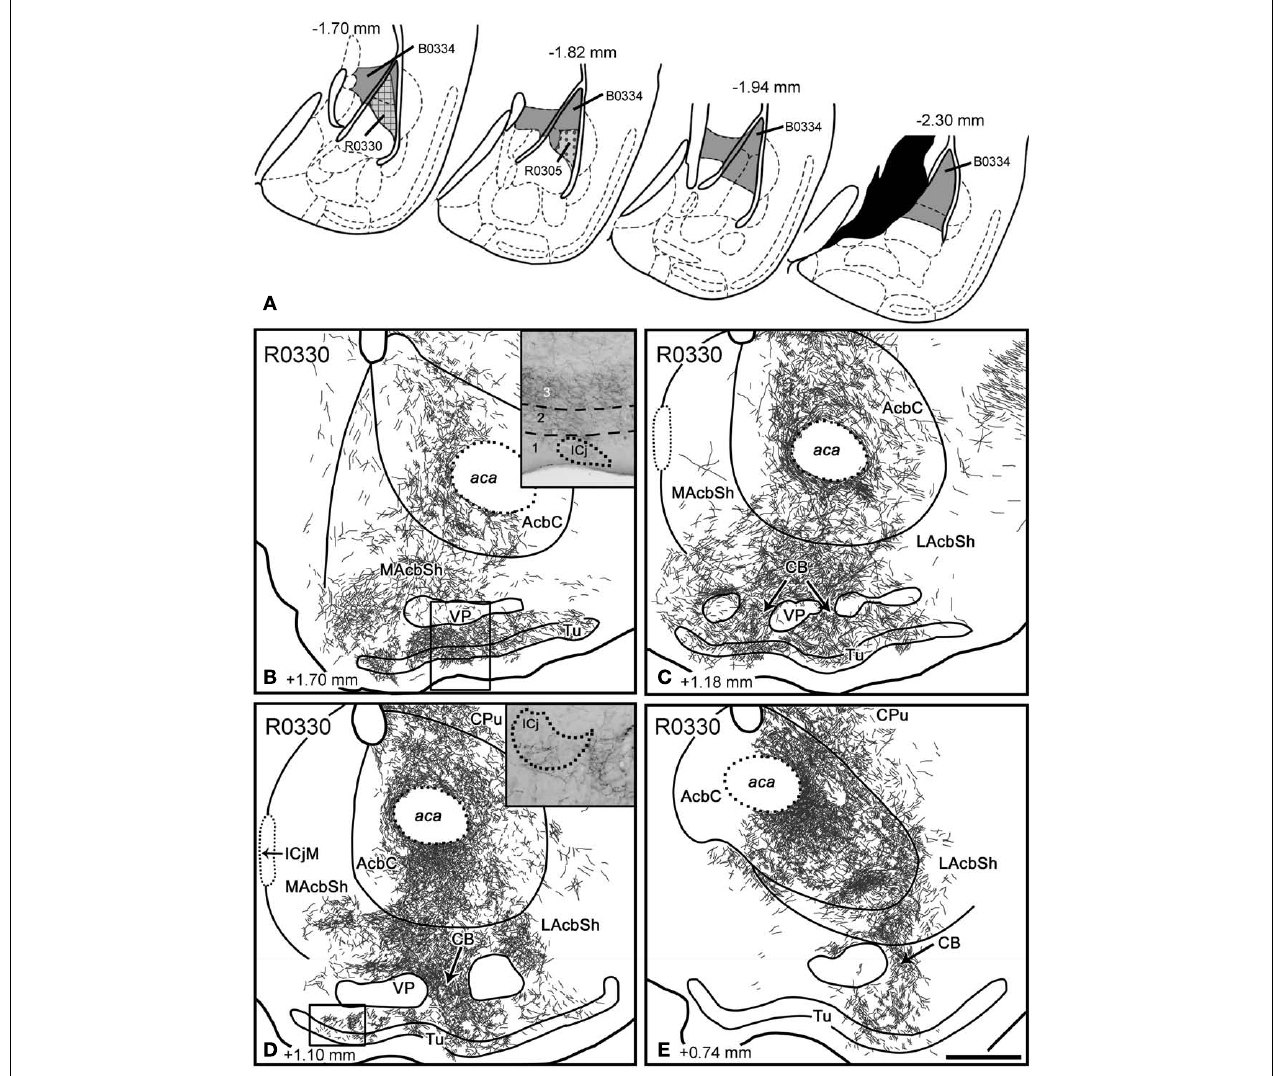
FIGURE 8 |Anterograde labeling in the ventral striatum after tracer injections in the lateral nucleus of the amygdala. (A) Semi-schematic drawings of frontal sections through the amygdala depicting the extent of tracer injections in the lateral nucleus.The antero-posterior coordinate relative to Bregma is indicated in each section. (B–E) Semi-schematic drawings of four frontal sections through the brain of a mouse that received an RDA